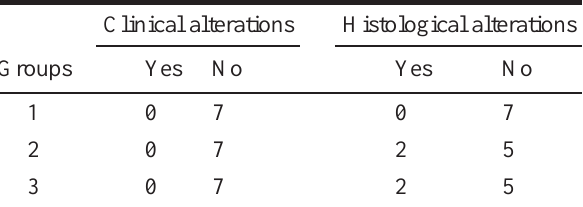
TABLE 2 - Clinical and histological findings from the